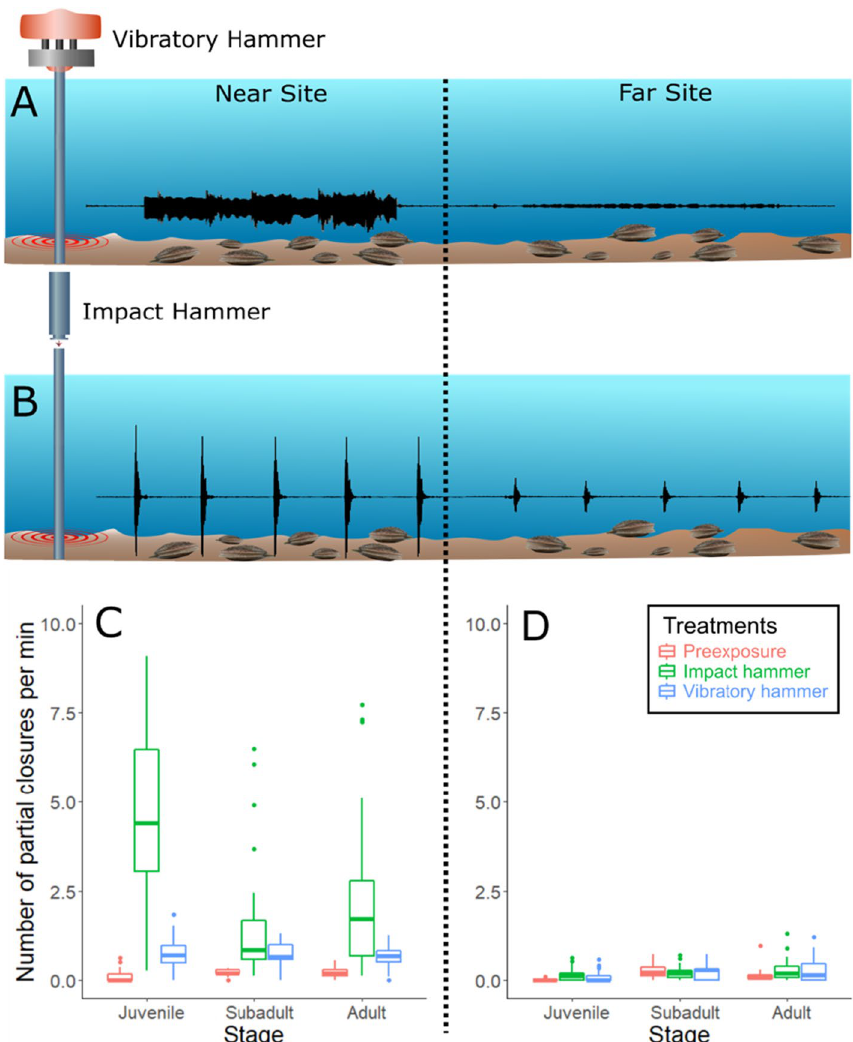
Figure 3. Pile driving induces behavioral responses in nearby scallops across all life stages. Top: experimental set-up showing a typical pile driving event used in this study, starting with the vibratory ( A ) and ending with the impact ( B ) hammers, lasting 30 min in total. Between 4 and 5 piles were successively driven per experimental day. Black waveforms highlight differences in signal types (i.e., A : continuous vs. B : impulsive) and amplitudes perceived by scallops at both sites. Bottom: response rates of scallops at near ( C ) and far ( D ) sites from the PD for all three tested stages (juveniles, subadults and adults) before PD occurred (i.e., preexposure, in red), during the impact (green) and vibratory (blue) hammer